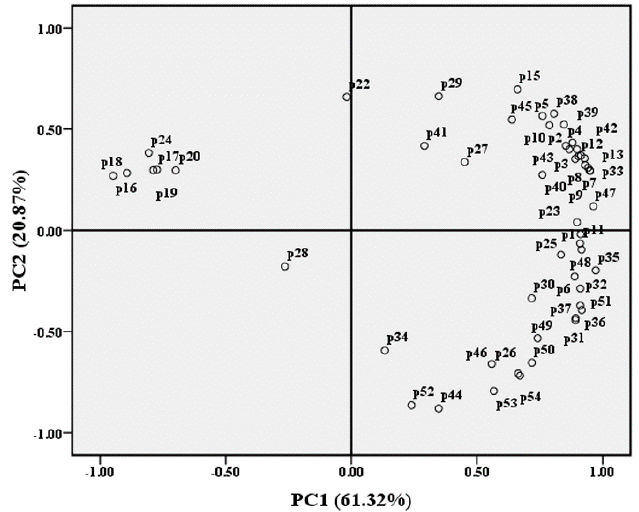
Figure 7. Loading plots of different phenolic compounds in PC1 and PC2.